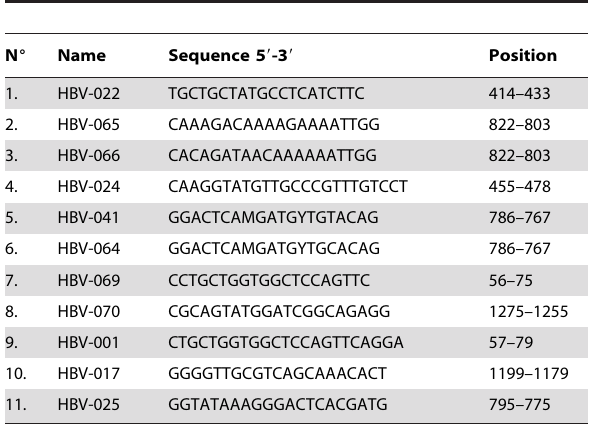
Table 1. HBV-specific primers for detection, genotyping, and mutational